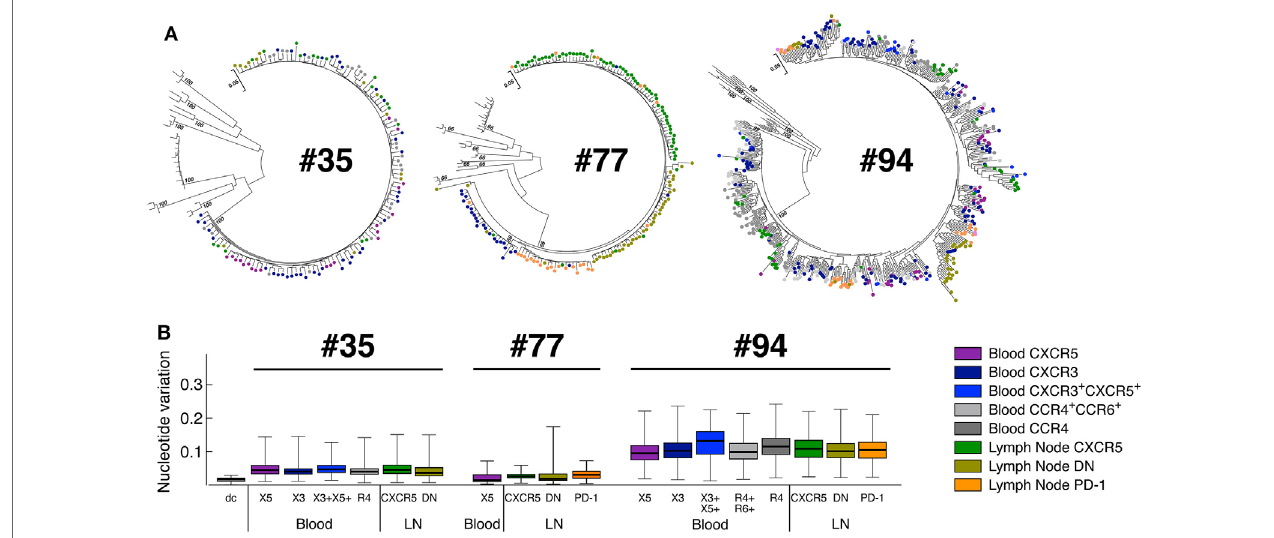
FigUre 5 | Phylogenetic relationship of HIV-1 envelope sequences derived from CD4 T-cell populations. Sequences of the highly variable EnvV1V4 region (Hxb 6540-7668) were derived from blood and LN memory CD4 T-cell populations isolated from aviremic-treated HIV-1-infected individuals ( N = 3). Virus quasi-species were amplified and sequenced [single molecule, real-time (SMRT) method/PacBio Systems]. (a) Phylogenetic relationship of HIV-1 envelope sequences derived from CD4 T-cell populations ( N = 3). The phylogenetic relationship was inferred by the Maximum Likelihood method based on the General Time Reversible substitution model (GTR + G). Each tree includes reference sequences from subtype B and non-B HIV-1-infected individuals. (B) Nucleotide variations observed within each blood and LN memory CD4 T-cell population estimated using the Gama distributed kimura-two-parameter. CD4 T-cell populations were color coded (a,B) . dc corresponds to the laboratory isolate control used to monitor sequence diversity induced by the method. “X3” corresponds to blood CXCR3-expressing CD4 T cells; “R4” corresponds to blood CCR4-expressing CD4 T cells; R4 + R6 + corresponds to blood CCR4 + CCR6 + CD4 T cells; “X5” corresponds to blood CXCR5-expressing CD4 T cells; And X3 + X5 + corresponds to blood CXCR3 + CXCR5 + CD4 T cells. “LN” corresponds to lymph